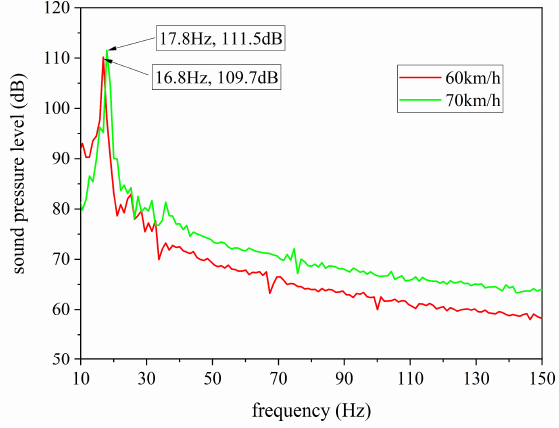
Figure 8. Comparison of spectra.